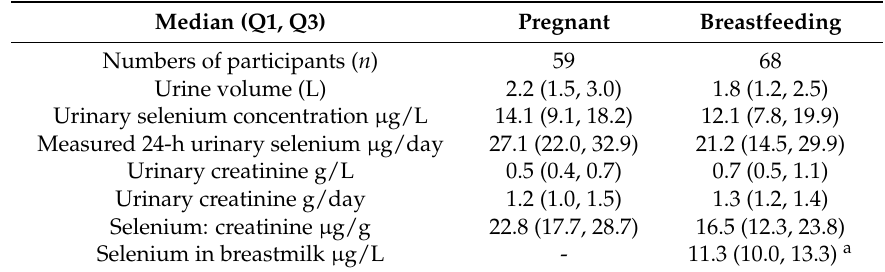
Table 2. Selenium and creatinine in 24-h urine samples from pregnant and breastfeeding women and selenium in breastmilk from breastfeeding women.